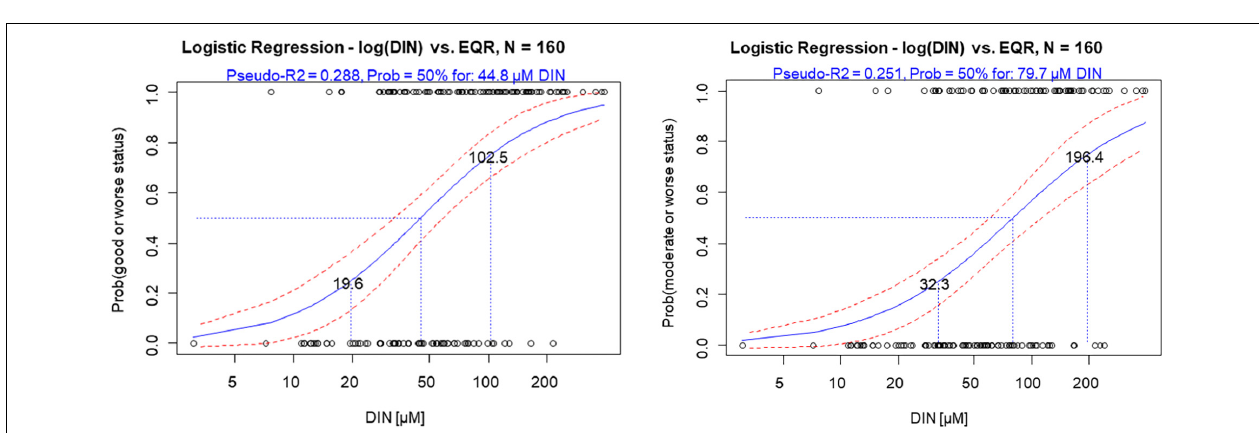
FIGURE 3 | Relationship between TN and TP for Lithuania (common type BT1). Points colored by phytoplankton EQS class (H, blue; G, green; M, yellow; P, orange; B, red), dotted line marks the mean N:P molar ratio, broken orange line ratio of 15:1. Green and blue lines mark contours of the good/moderate and high/good boundaries predicted from the bivariate model. The vertical and horizontal dotted lines indicate the predicted boundaries and respective upper and lower range.